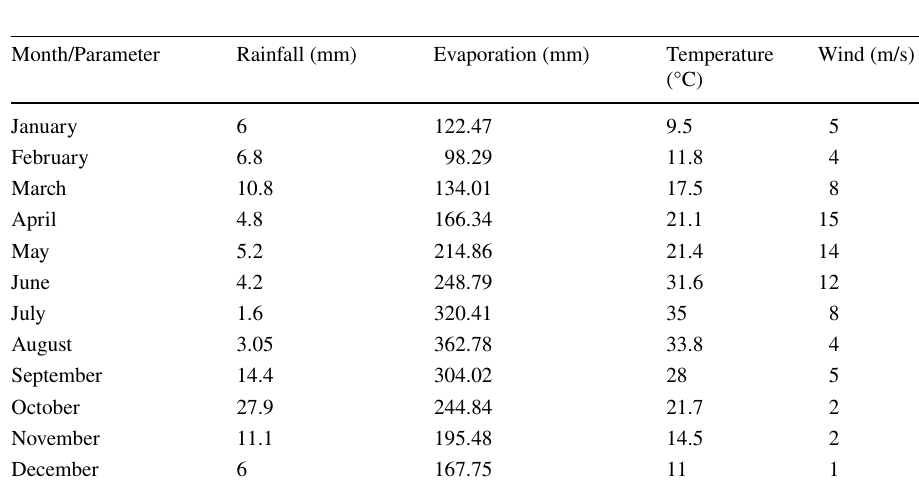
Fig. 2 Ombrothermal diagram of Gaussen of Bechar city (ken- douci et al. 2019)